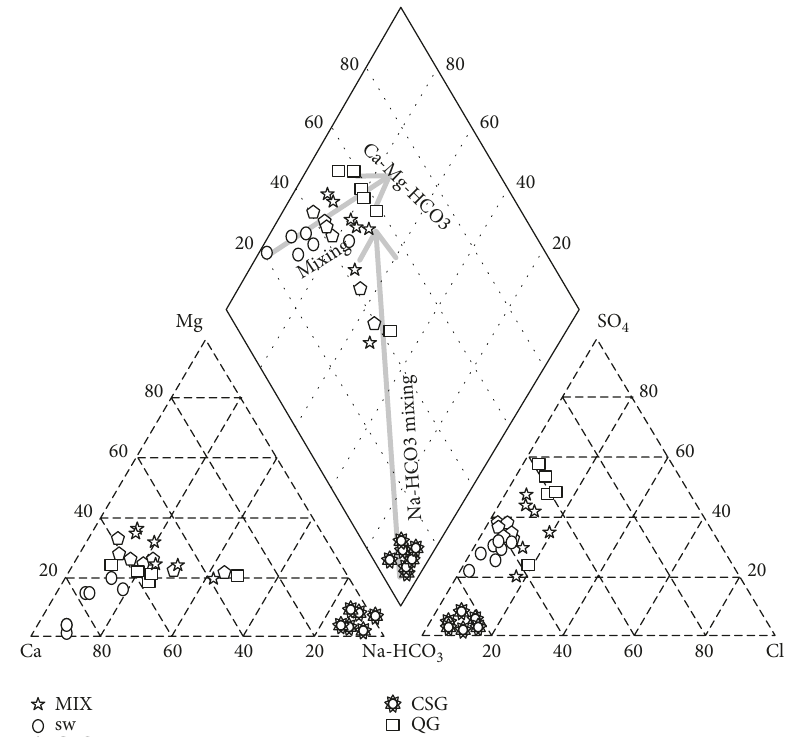
Figure 2: Piper trilinear diagram of the water samples. MIX: mixing water; CLG: Cambrian aquifer groundwater; QG: Quaternary aquifer groundwater; sw: surface water; CSG: coal-bearing sandstone aquifer groundwater.